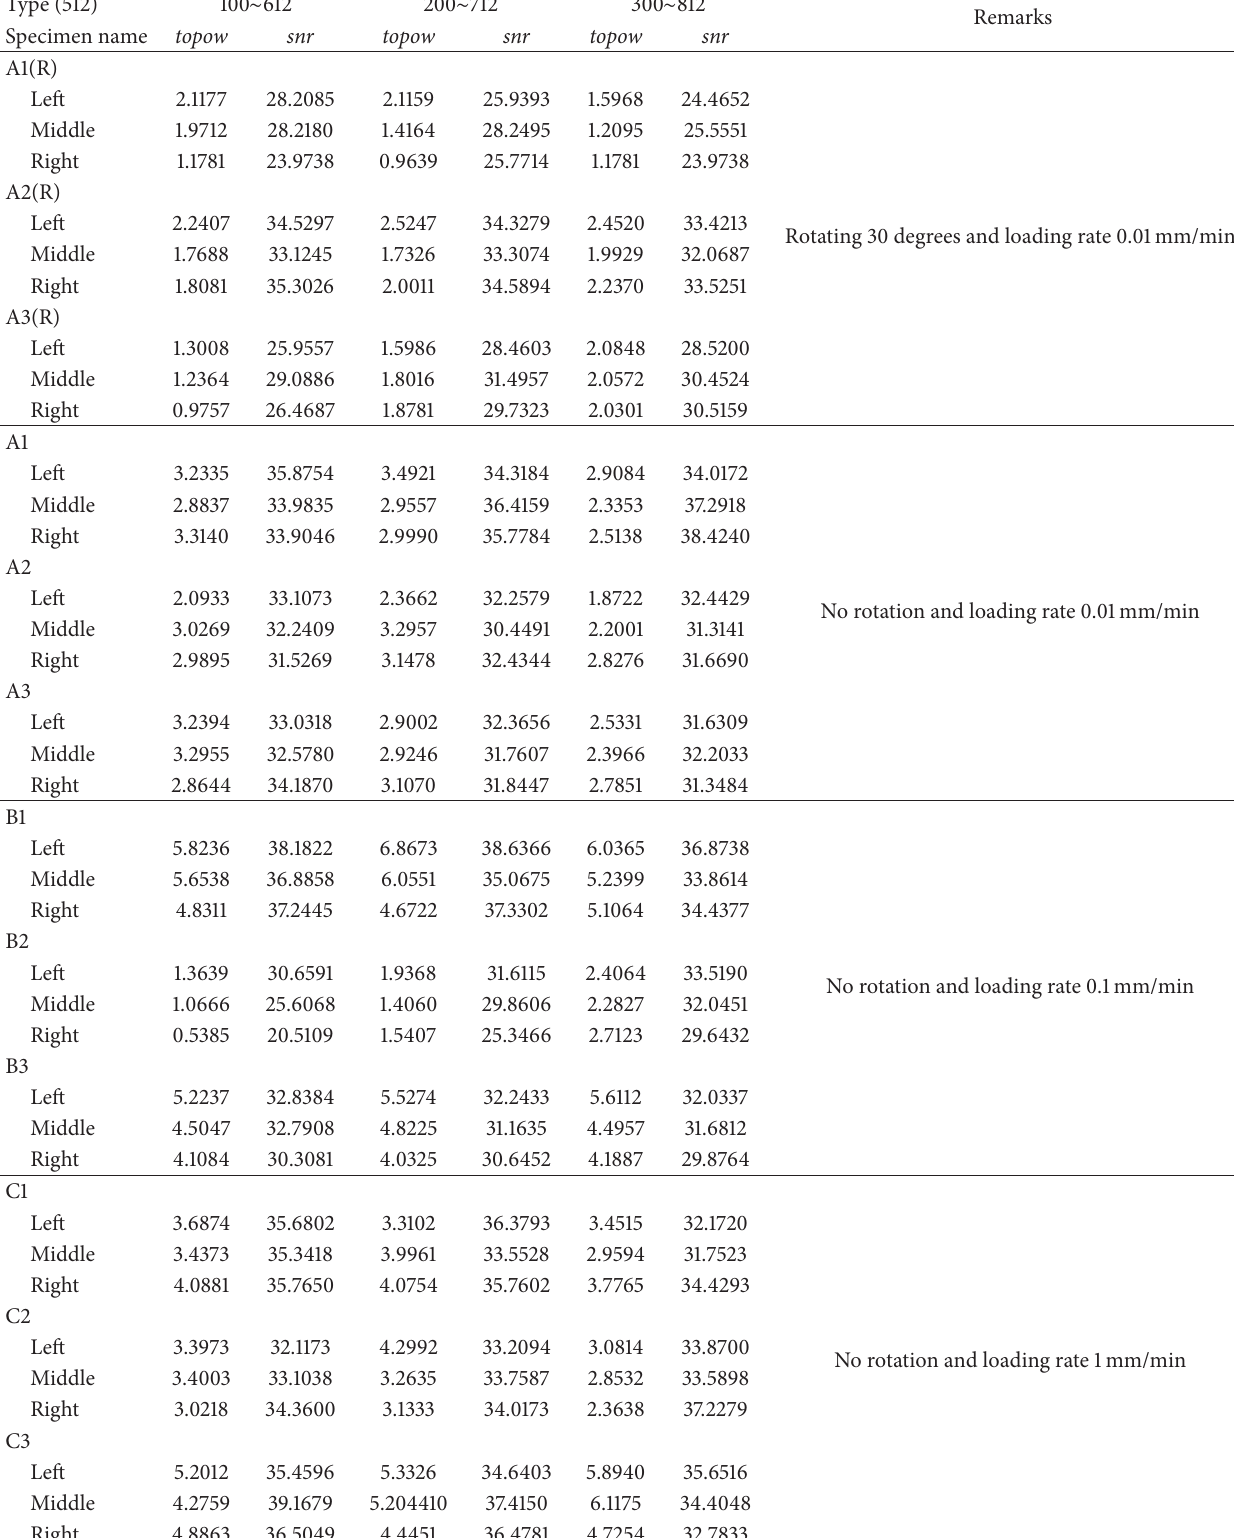
Table 1: The topow and snr values of every rock specimen’s three lines and three